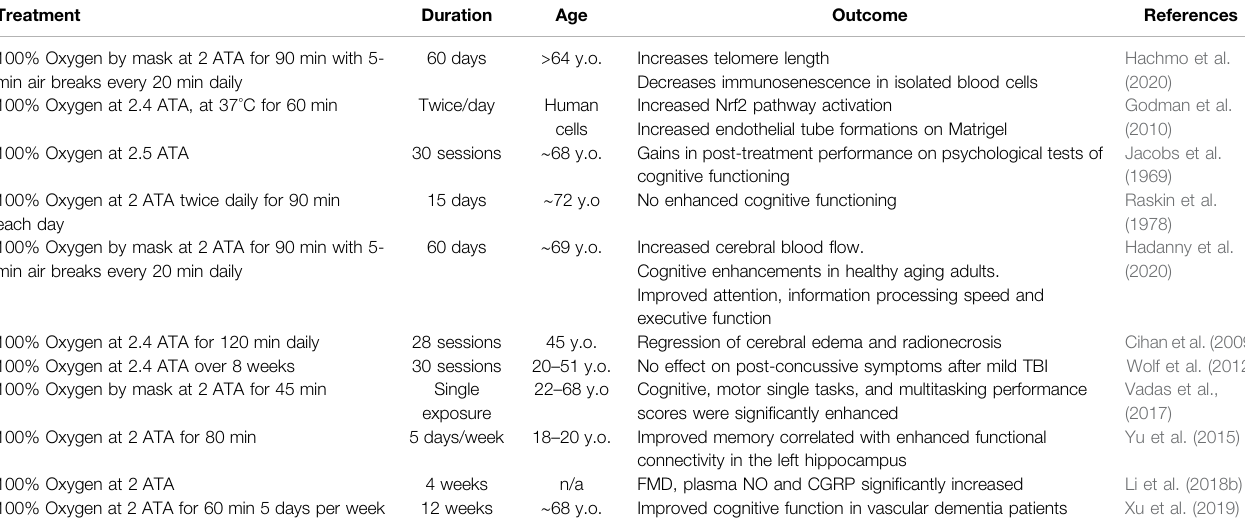
TABLE 1 | Summary of relevant clinical fi ndings testing the ef fi cacy and safety of HBOT for the treatment of age-related vascular cognitive impairment and dementia. The highlightedstudiespresentexistingevidenceindicativeofapotentialtherapeuticroleforHBOT-inducedhyperoxiaagainstage-relatedcerebromicrovascularpathologies contributing to cognitive impairment, dementia, and decreased healthspan. Vascular clinical evidence for